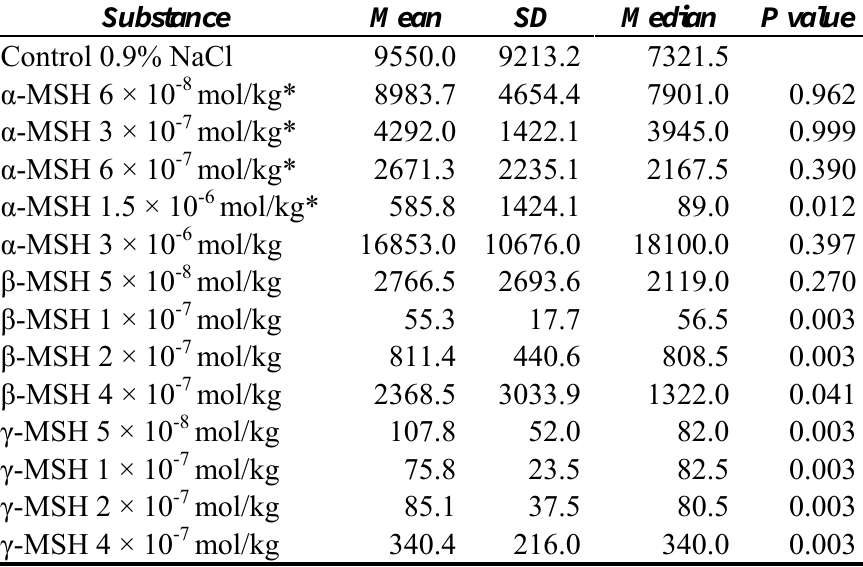
Table 3. Alanine aminotransferase activity (U/L) in plasma 24 h after acetaminophen administration (150 mg/kg i.g). Tested substances were given intraperitoneally 1 h before acetaminophen. P value is a result of comparison with the control group (Steel’s